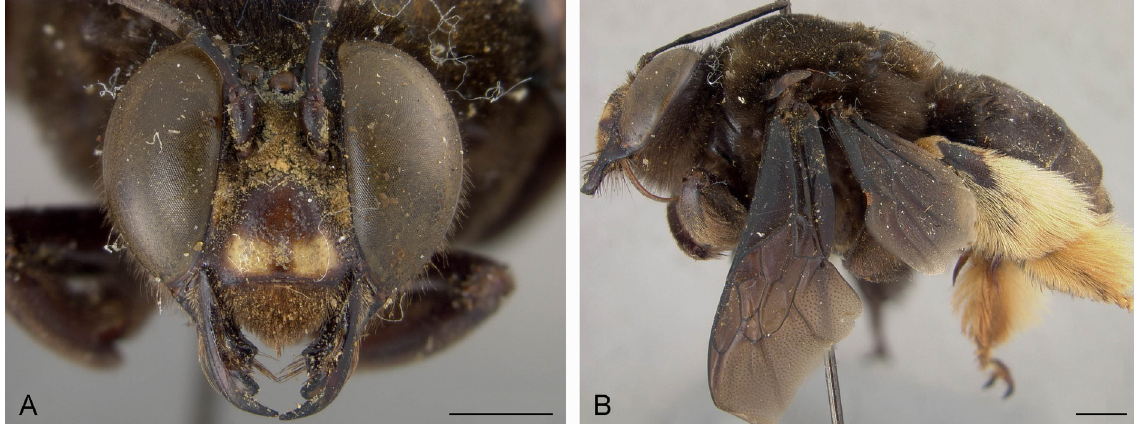
Fig. 18. Centris fusciventris caurensis Cockerell, 1919, holotype, ♂ (NMNH; USNM ENT 00534189). A . Frontal view. B . Habitus, lateral view. Scale bars: A = 1 mm; B = 2